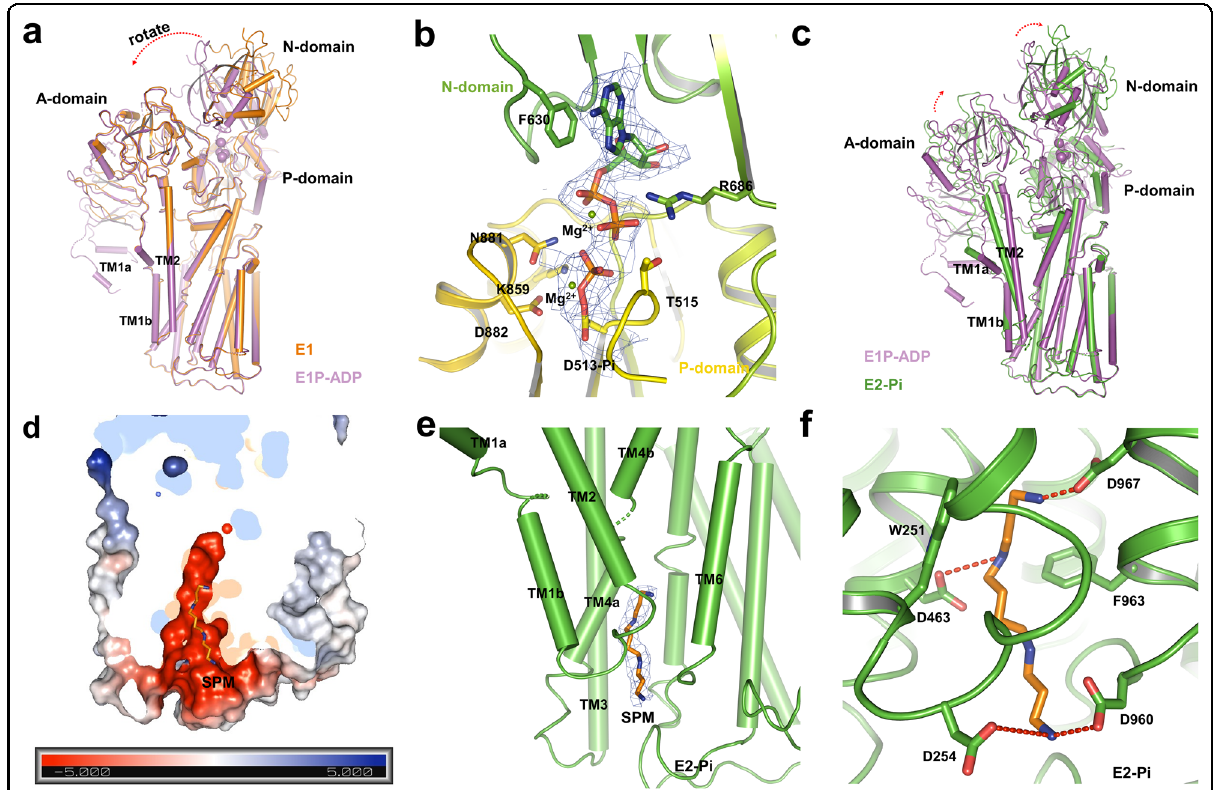
Fig. 3 Comparisons of different intermediate states and substrate-binding site. a Conformational changes of ATP13A2 from the E1 state (orange) to the E1P-ADP state (purple) are shown. b Close-up view of the phosphorylation sites in E1P-ADP state. ADP and Pi are shown as sticks, and Mg 2 + are shown as spheres. Densities are shown as blue mesh, contoured at 5 σ . c Conformational changes of ATP13A2 from the E1P-ADP state (purple) to the E2-Pi state (green) are shown. d Heatmap of the surface electrostatics of TMs shows a substrate-binding cavity. The SPM molecule is shown as sticks. e Cryo-EM density showing the bound substrate SPM (blue mesh, 6 σ ). The SPM molecule is shown as sticks. f Ribbon representation of the interaction of TMs with SPM. The SPM molecule is shown as